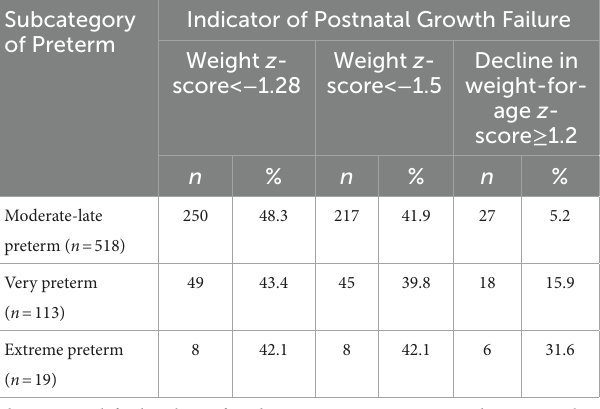
TABLE 2 Incidence of postnatal growth failure across subcategories of preterm. Subcategory of